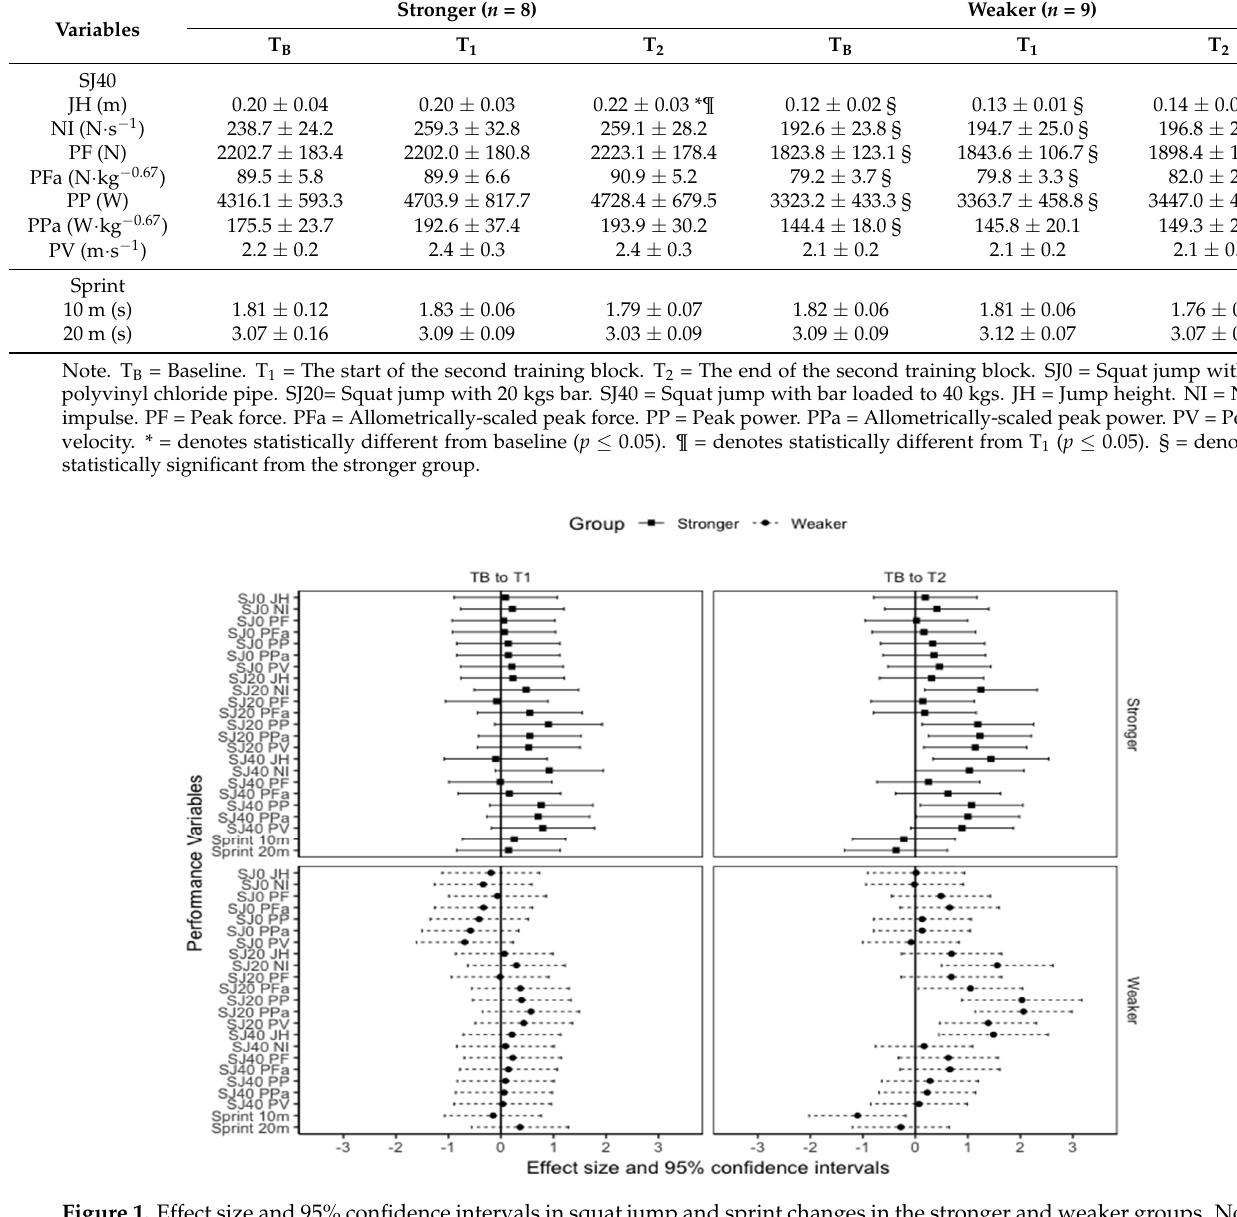
Figure 1. Effect size and 95% confidence intervals in squat jump and sprint changes in the stronger and weaker groups. Note. TB = Baseline. T1 = The start of the second training block. T2 = The end of the second training block. SJ0 = Squat jump with a polyvinyl chloride pipe. SJ20 = Squat jump with 20 kgs bar. SJ40 = Squat jump with bar loaded to 40 kgs. JH = Jump height. NI = Net impulse. PF = Peak force. Pfa = Allometrically-scaled peak force. PP = Peak power. PPa = Allometrically-scaled peak power. PV = Peak velocity.